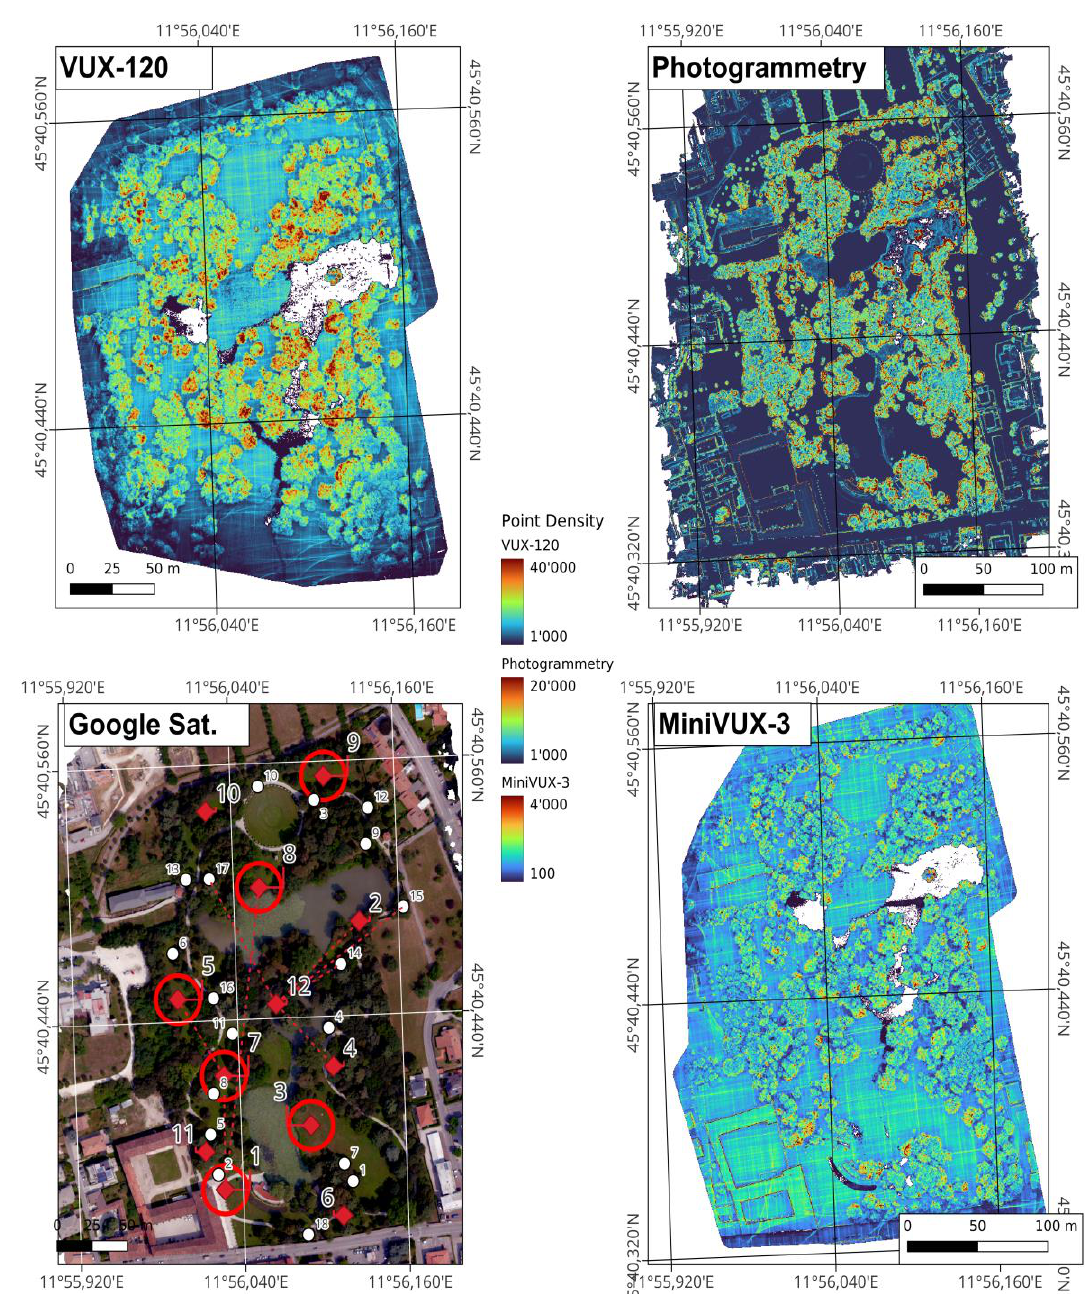
Figure 1. Study area with point cloud densities and GPSs in red and white circles, red circles are big targets, white circles are smaller targets. Red dashed line is the distances measured with the total